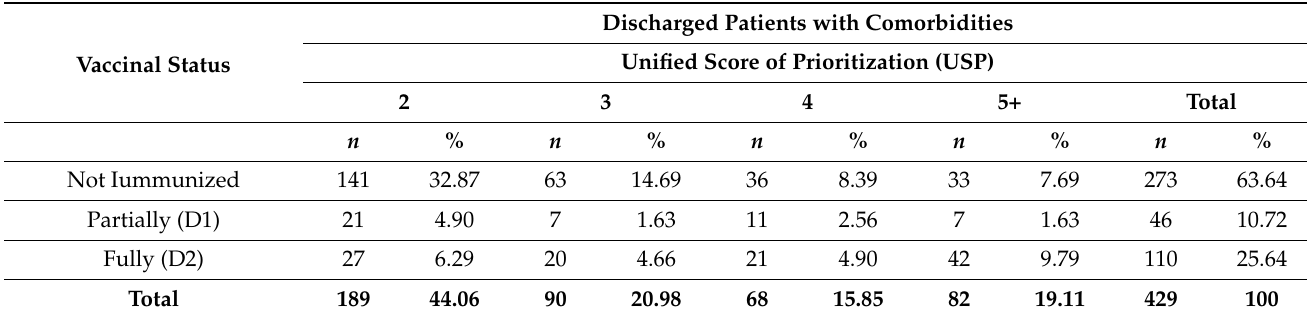
Table 2. Discharged patients with comorbidities admitted between June and August 2021 and grouped according to their vaccinal status and the Unified Score for Prioritization (USP).